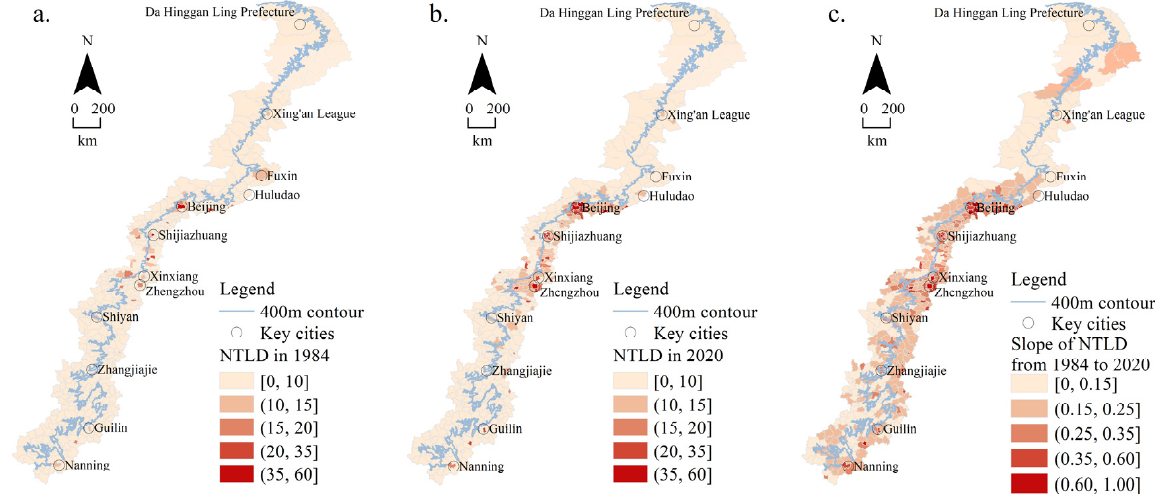
Figure 8. Nighttime lighting densities: ( a ) in 1984; ( b ) in 2020; ( c ) slope from 1984 to 2020.